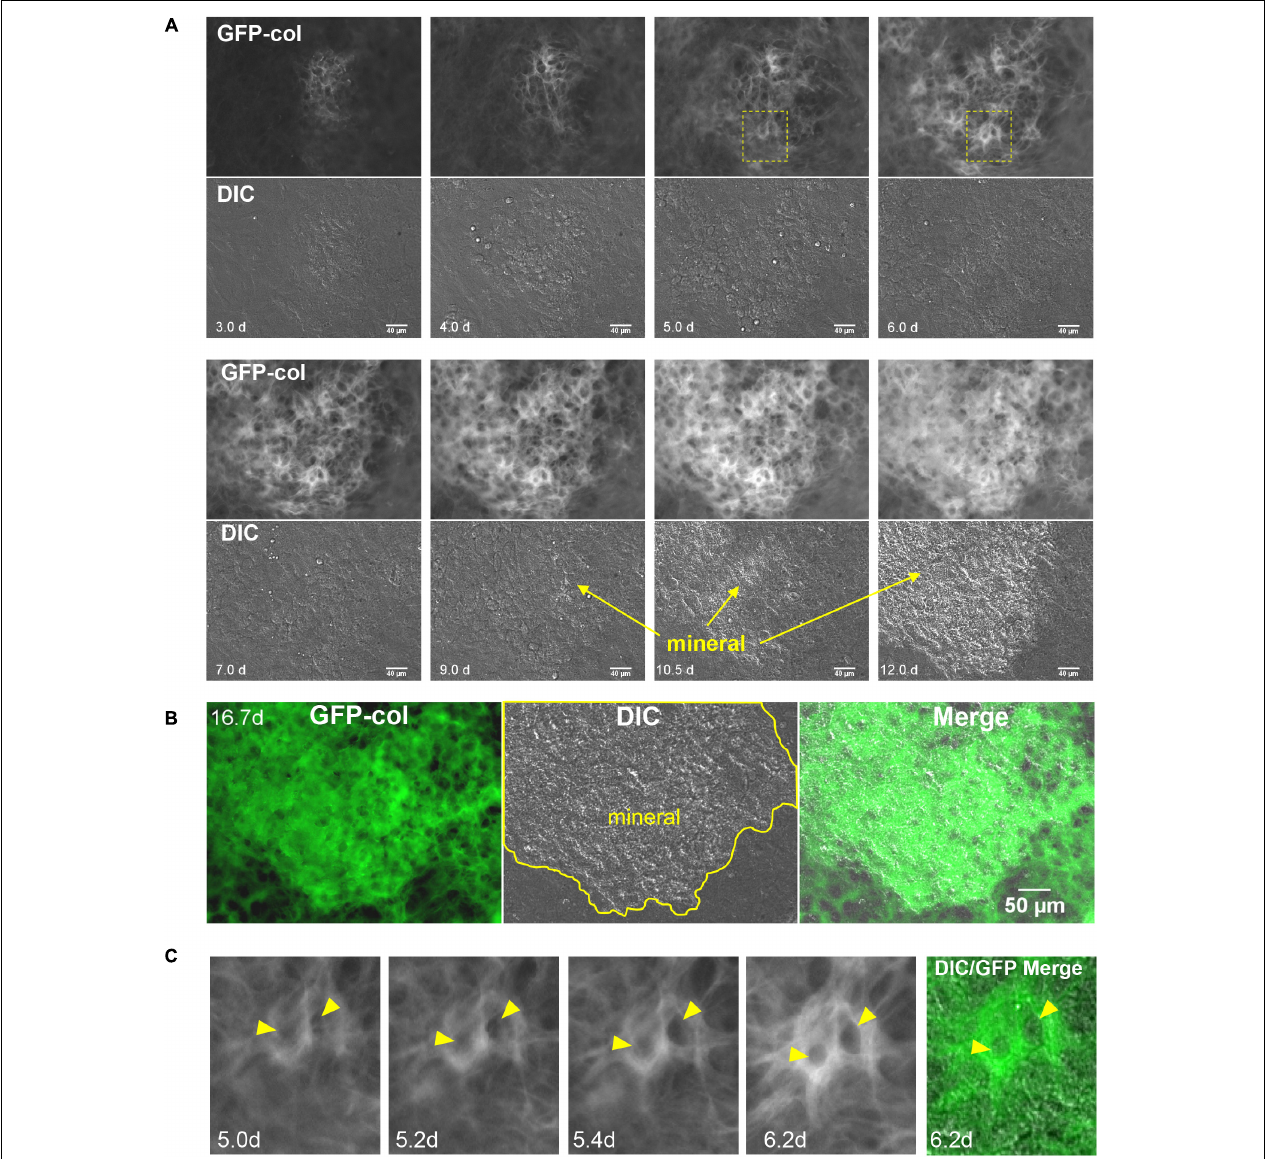
FIGURE 2 | Live cell imaging of collagen assembly dynamics in long-term osteogenic calvarial cell cultures. (A) Still frames from timelapse imaging showing formation of a mineralized bone nodule from its initial condensation at day 3 to mineralization by day 12. GFP-collagen is shown in the upper panels and DIC images are shown in the lower panels. Mineral deposition can be seen on the DIC images and is initiated around day 9 (bar = 40 µ m). To appreciate the dynamic nature of this collagen assembly please view Supplementary Movies 1 – 4 . (B) Still frames from day 16.7 in the same timelapse series showing GFP-collagen, DIC and merged images. Note that the mineral is deposited exclusively in the collagen-rich focal area (bar = 50 µ m). (C) Still frames showing an enlargement of the boxed area in ( A), illustrating GFP-collagen dynamics during the formation of two osteocyte lacunae (arrowheads) within the bone matrix over days 5.0–6.2. A merged GFP-collagen/DIC image is shown at right for the 6.2 h time point. To view this dynamically, please see Supplementary Movie 3 ,